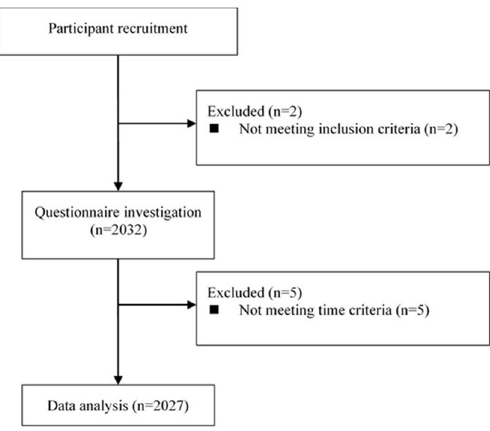
Figure 2. Flowchart depicting passage of